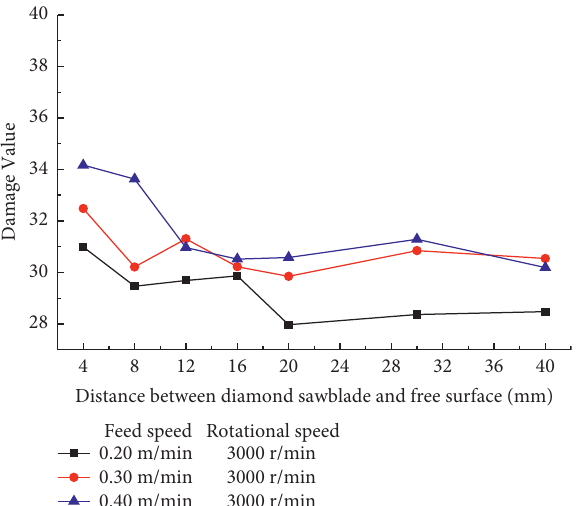
Figure 8: Variation curve of the rock damage value and distance between the sawblade and rock free